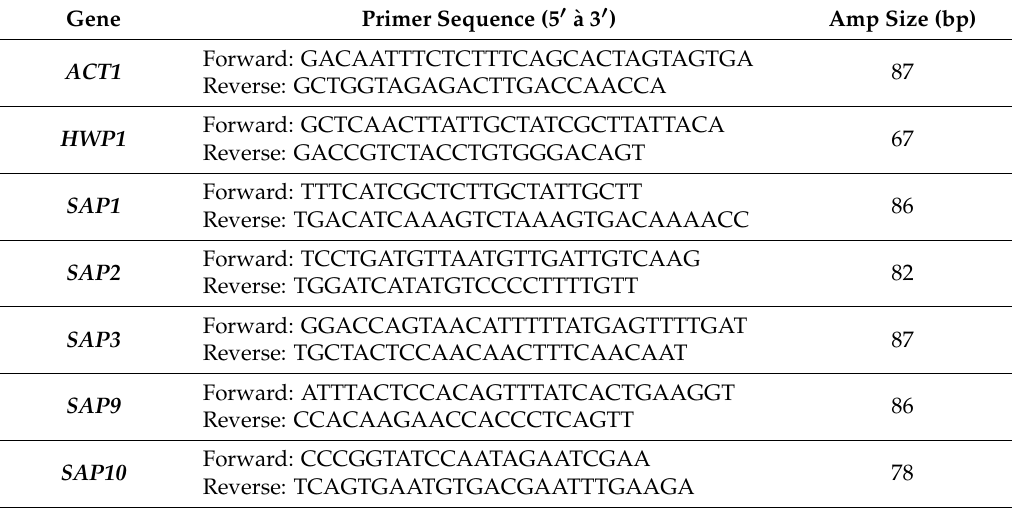
Table 1. Primer sequences used for the